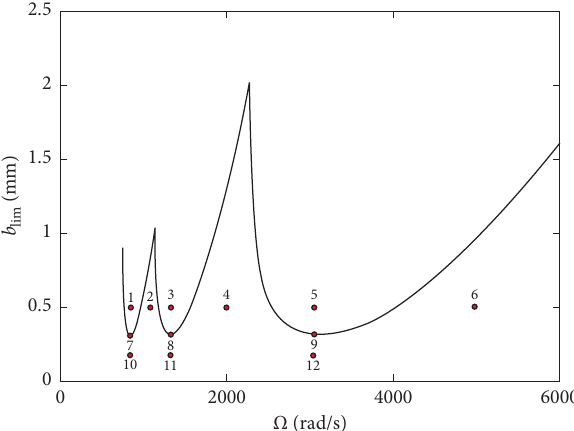
Figure 3: Positions of the parameter points on the plane of the stability lobes.